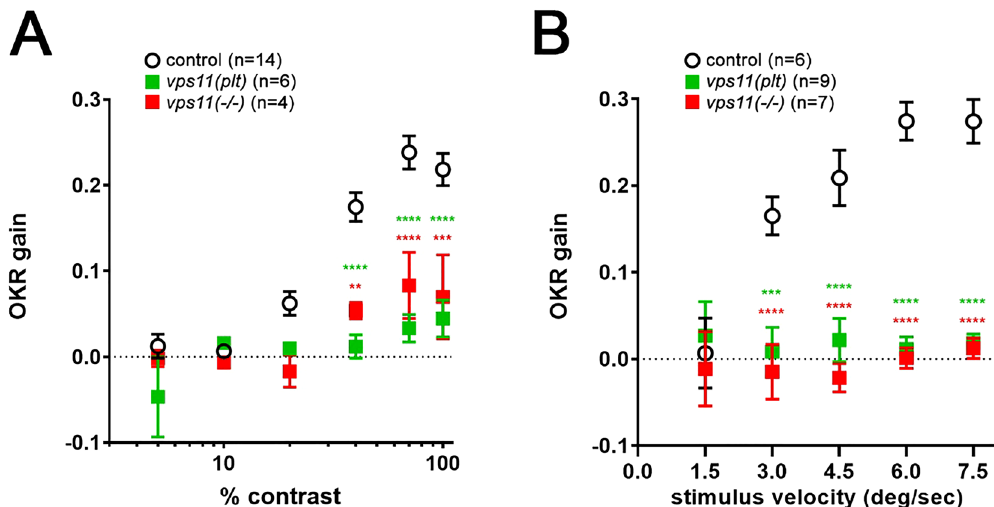
Figure 4. Visual function is compromised in vps11(plt) and vps11 (−/−) mutants. Optokinetic response of larval vps11(plt) and vps11 (−/−) homozygotes compared with sibling controls as a function of ( A ) contrast and ( B ) stimulus velocity. Asterisks indicate significant differences from controls (2-way ANOVA with Sidak’s multiple comparison test) ** P < 0.01, *** P < 0.001, **** P < 0.0001.